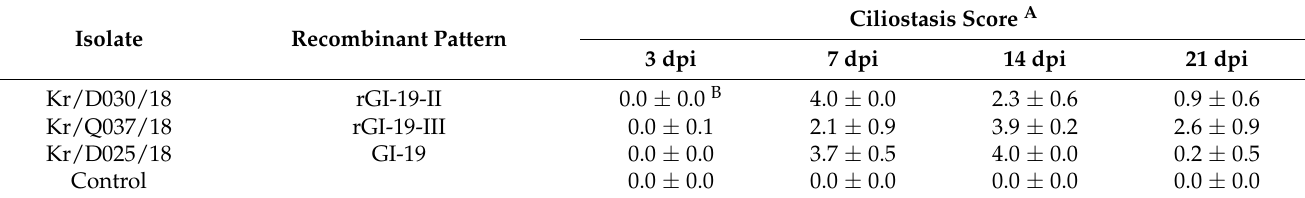
Table 2. Tracheal ciliostasis scores in SPF chickens infected with IBV isolates.